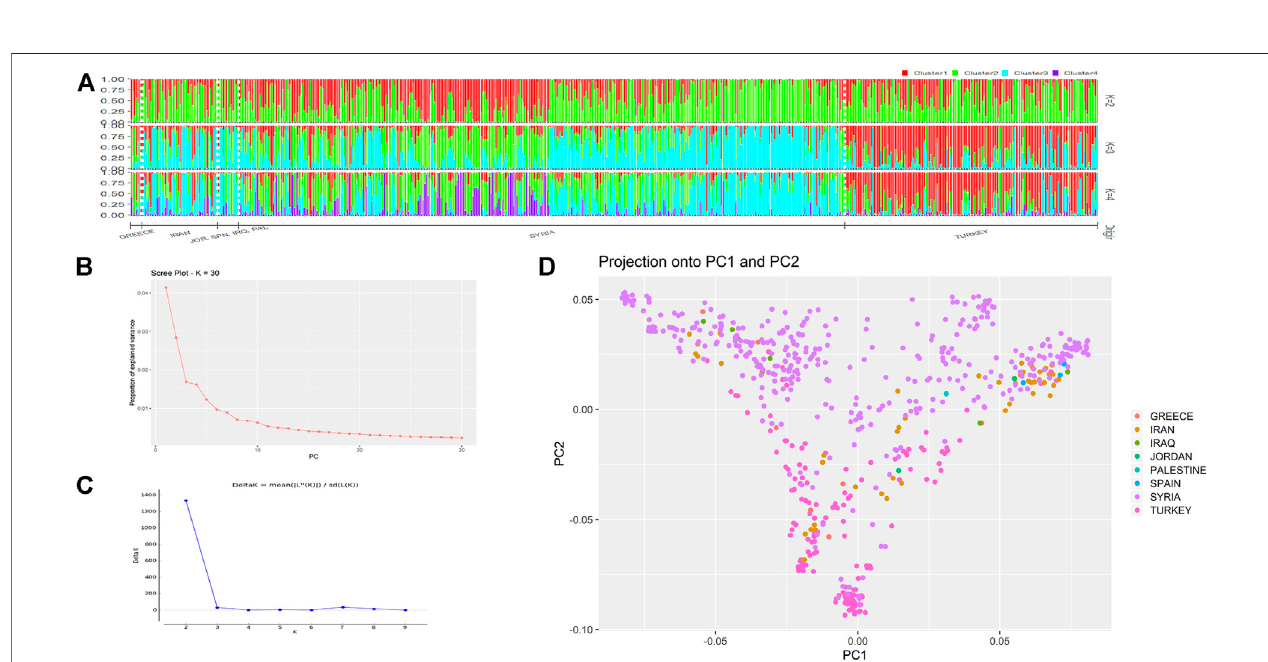
genetic variation (97.5%) was observed within the subpopulations. The genetic variance between two subpopulations was 4.2% in DAPC-based AMOVA, which